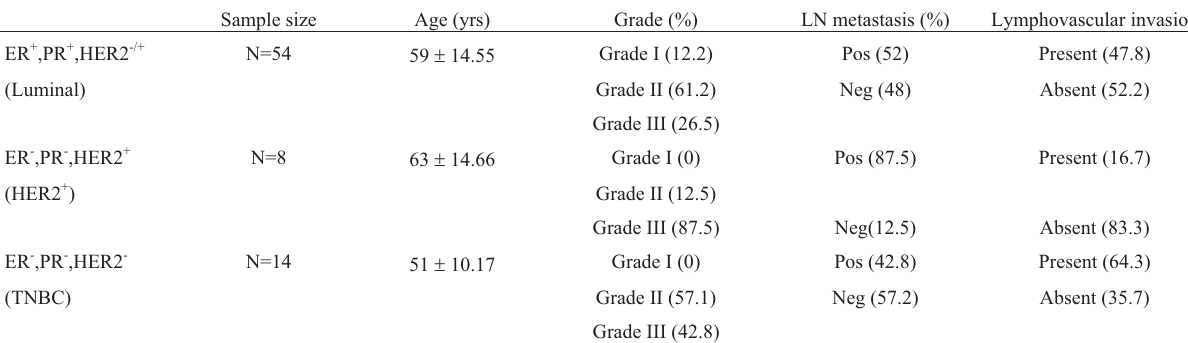
Table 1 - Clinical and histopathological